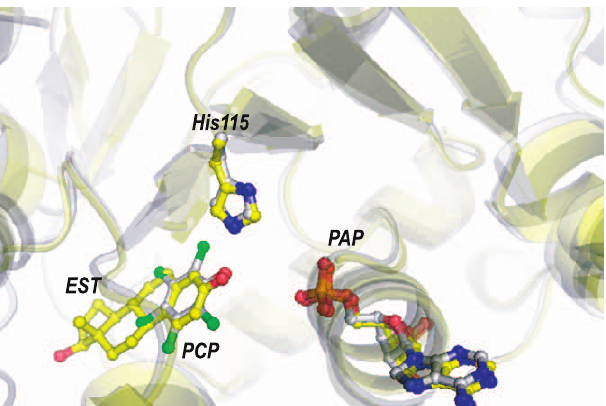
Figure 6. The Superimposition of the Active Sites of the SULT1E1-PAP- 17 b -estradiol Complex (1AQU) and the SULT1C2-PAP-PCP Complex (2GWH) The SULT1E1-PAP-17 b -estradiol complex is shown in yellow, and the SULT1C2-PAP-PCP complex is shown in grey. The PCP (chlorine atoms in green) and 17 b -estradiol (EST) molecules are highlighted along with the catalytic His115 and PAP. See text for